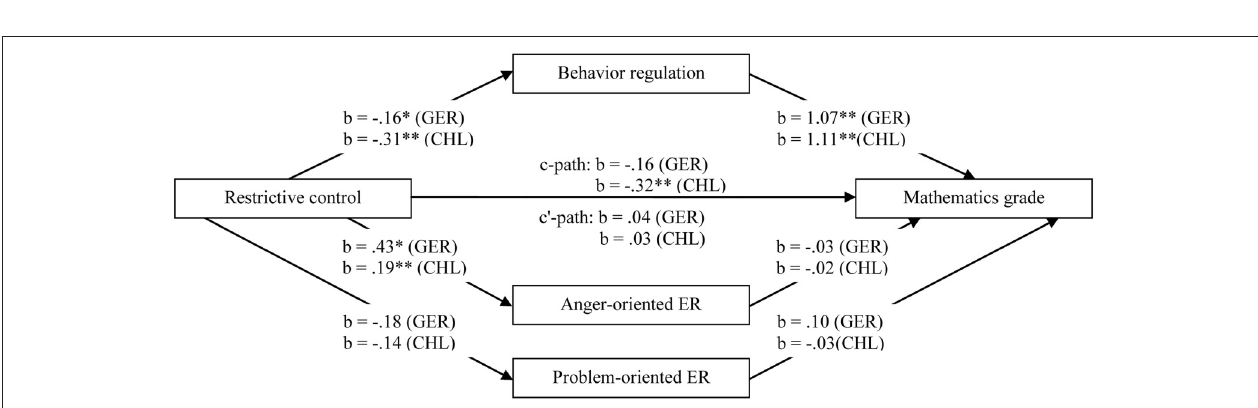
FIGURE 1 | Multiple mediation test of the relation between maternal restrictive control and language grade mediated by behavior regulation, anger- and problem-oriented emotion regulation. Models were tested separately for the German and the Chilean samples. N (Germany)=76; N (Chile)=167; b=unstandardized regression coefficient, controlled for intelligence, age, and gender; GER=German sample; CHL=Chilean sample; ER= emotion regulation; * p < 0.05; ** p < 0.01.